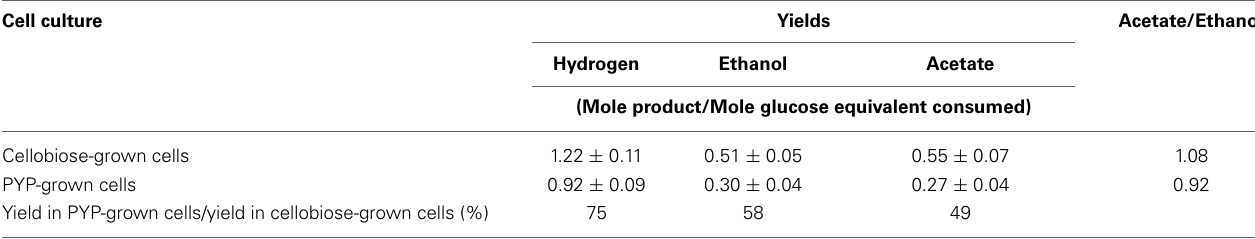
Table 1 | Hydrogen, ethanol and acetate production at the late stationary phase of C. thermocellum culture. Cell culture